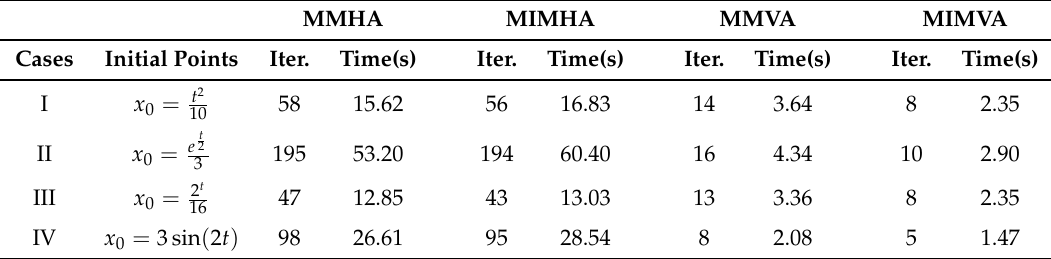
Table 1. Computation results for Example